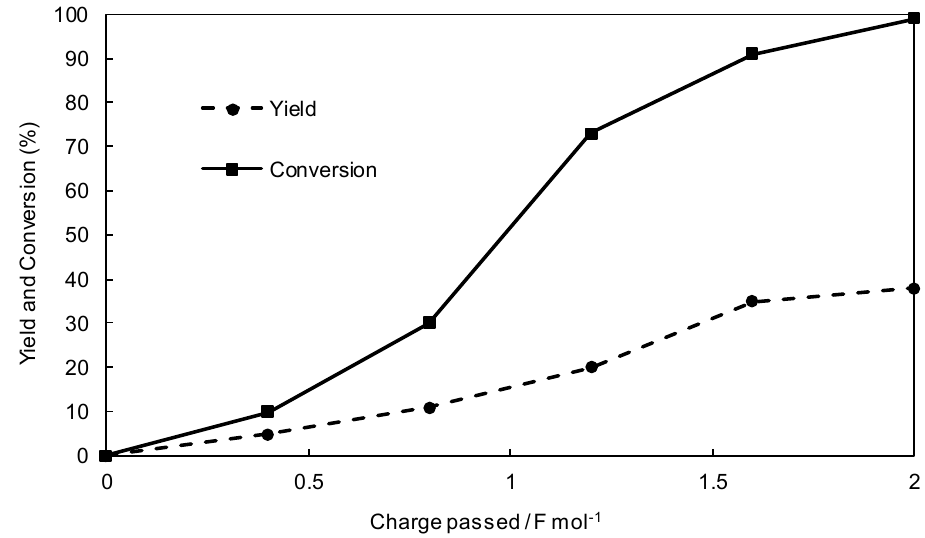
Figure 1. Effect of the electricity on the yield of 3a and the conversion of 1a .